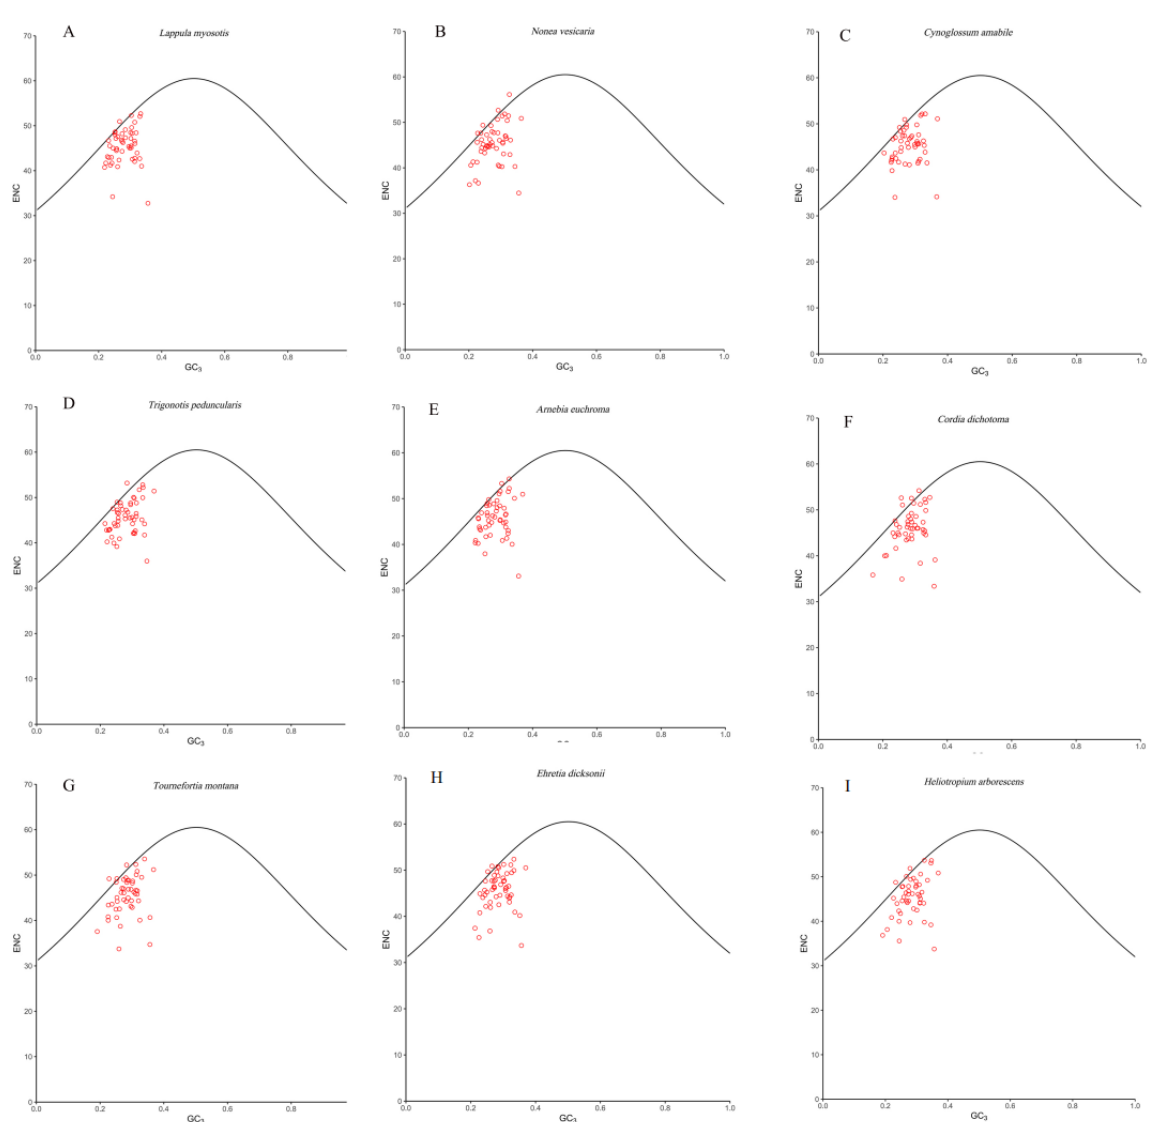
Figure 4. ENC plot analyses show the relationship between ENC and GC3.